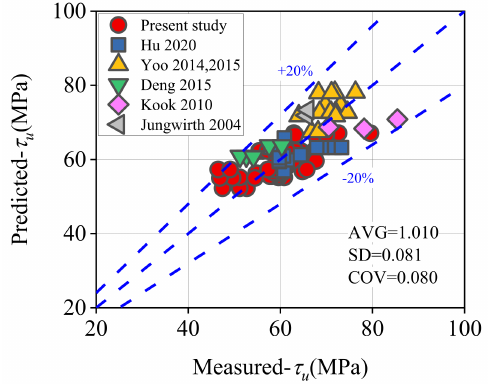
Figure 15. Comparative measured and predicted bond strength of